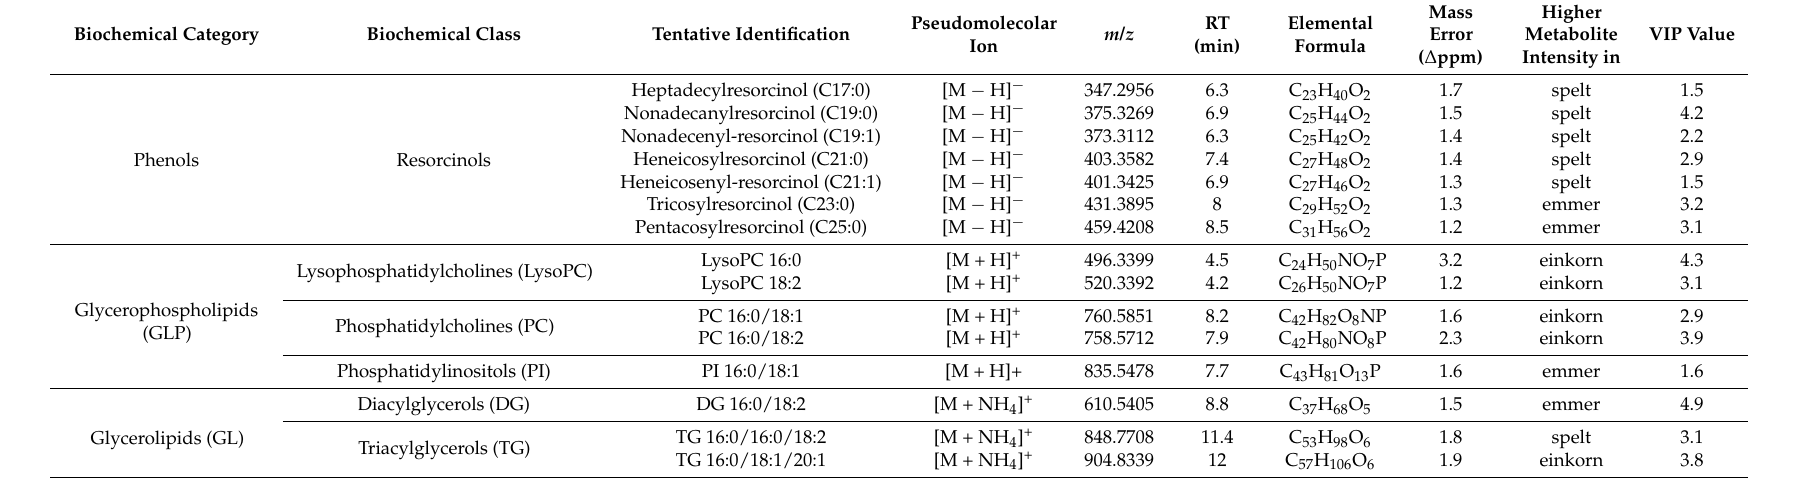
Table columns: pseudomolecular ion = positive and negative ionization adduct; m / z = mass-to-charge ratio in daltons; RT = ion retention time in minutes; elemental formula = elemental composition of the neutral molecule; mass error ppm = ∆ in ppm between the detected m / z and the theoretical m / z ; higher metabolite intensity in = ion spectral intensity higher in emmer, einkorn, or spelt as indicated; VIP value = Variable Influence in Projection